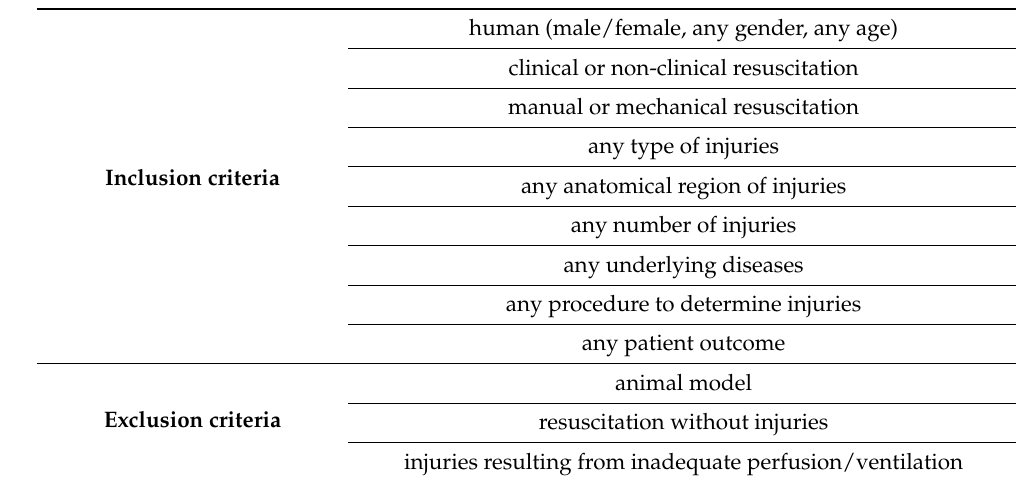
Table 2. Inclusion and exclusion criteria for the scoping